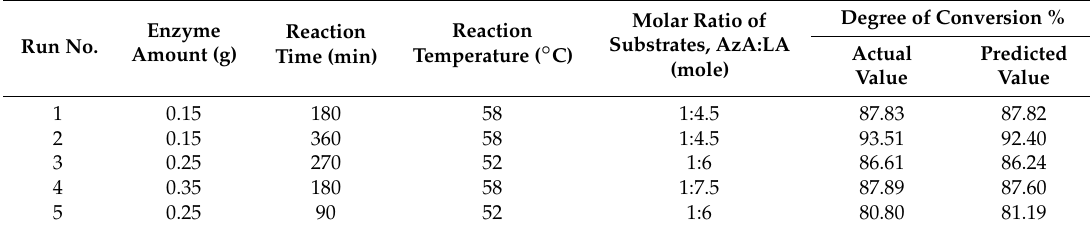
Table 2. Central composite rotatable design matrix and result for the model of dilaurylazelate ester